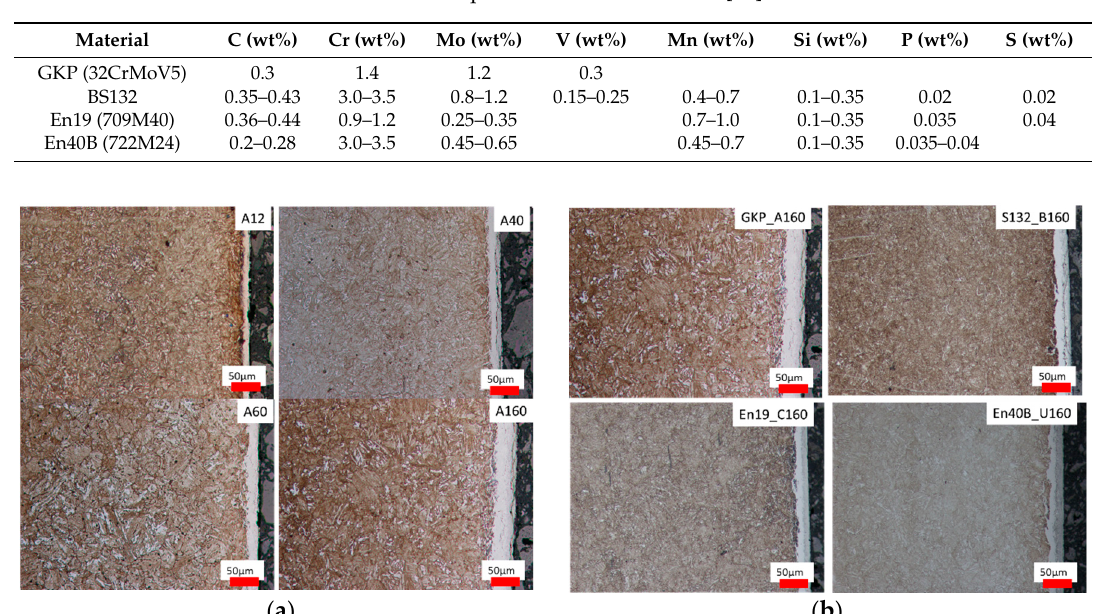
Table 3. Case depths (mm) of the studied samples. Table 2. Compositions of the materials [19].